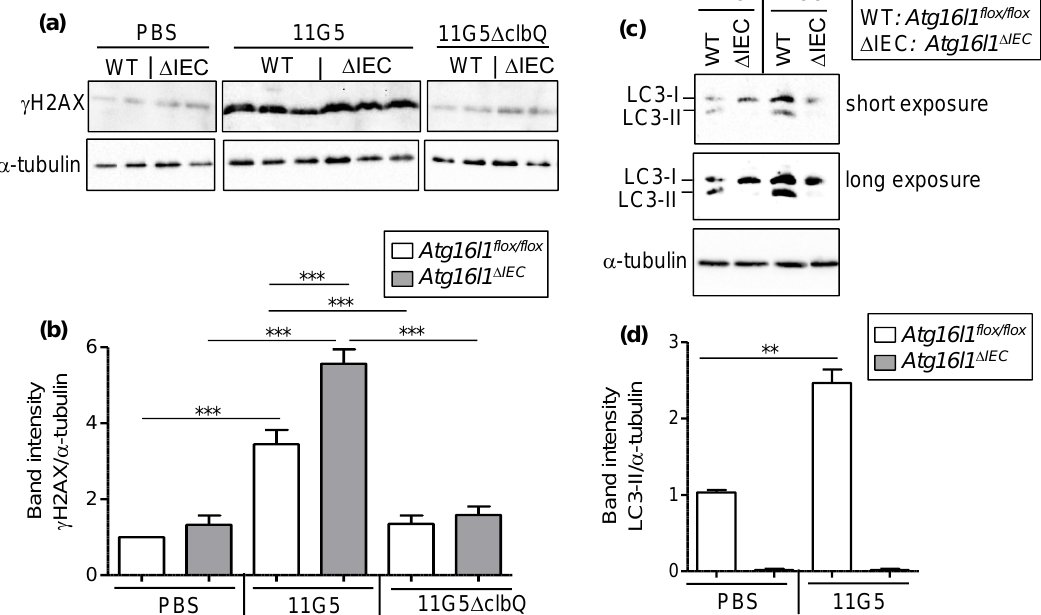
Figure 6. CoPEC infection increases the level of DNA damage marker in the colons of chronic DSS-treated mice, and this was further enhanced by intestinal autophagy deficiency. Atg16l1 flox/flox (WT) and Atg16l1 ∆IEC (∆IEC) mice were treated with streptomycin for 3 days and then received water for 24 h before being orally administered (day 0) with PBS or with 10 9 colony-forming units of 11G5 bacteria or the mutant 11G5∆clbQ. ( a , c ) Representative western blot analysis of γH2AX ( a ) and LC3 ( c ) levels in the colonic mucosa. The uncropped Western blots have been shown in Figure S1. ( b , d ) Quantification of western blot band intensity from N = 6/group. Results are means ± SEM. ** p ≤ 0.01; *** p ≤ 0.001 by one-way ANOVA, followed by a post-test Bonferroni.